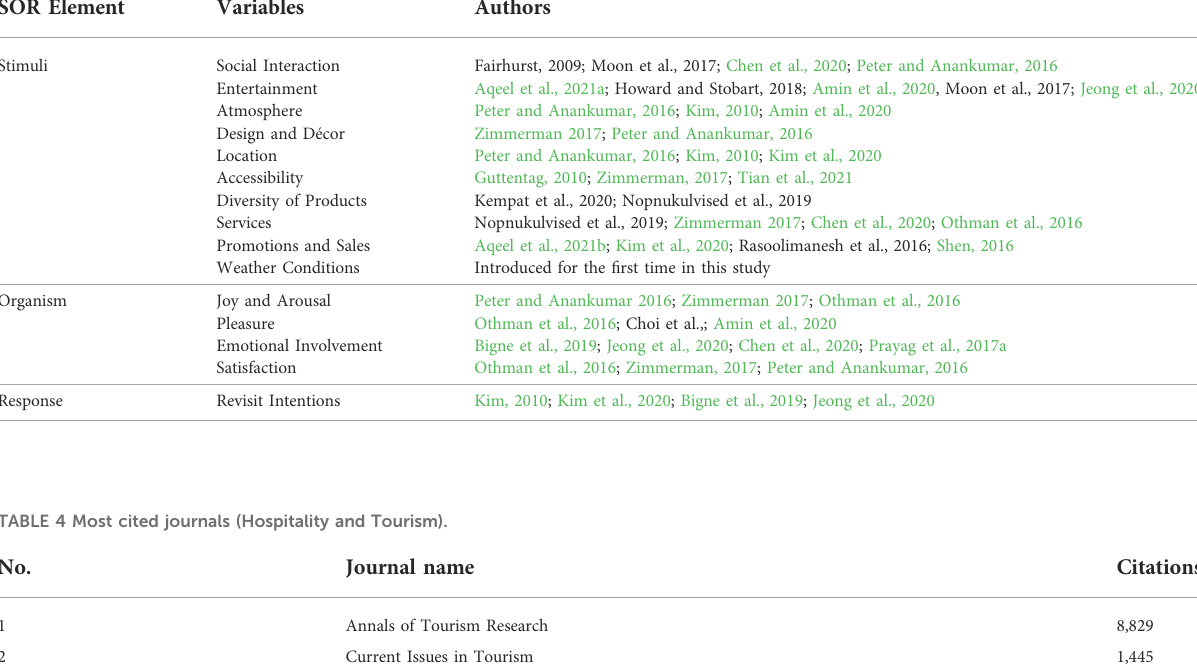
TABLE 3 SOR Theory elements.